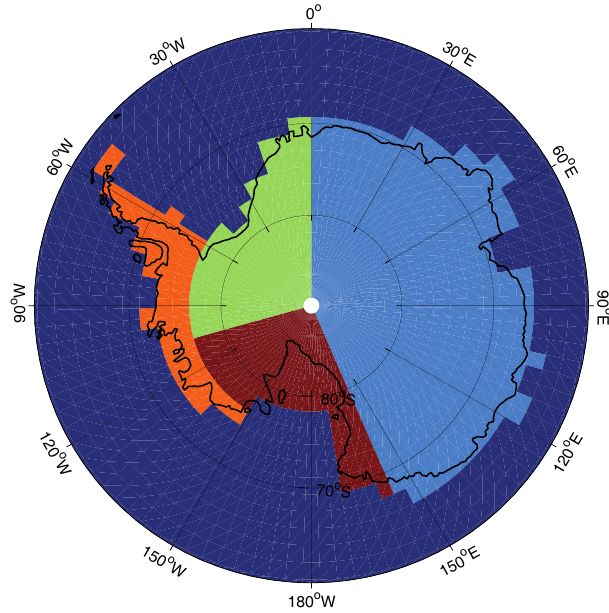
Fig. 3. Antarctic drainage basins. Moisture and heat fluxes asso- ciated with ice discharge are evenly distributed to coastlines within each drainage